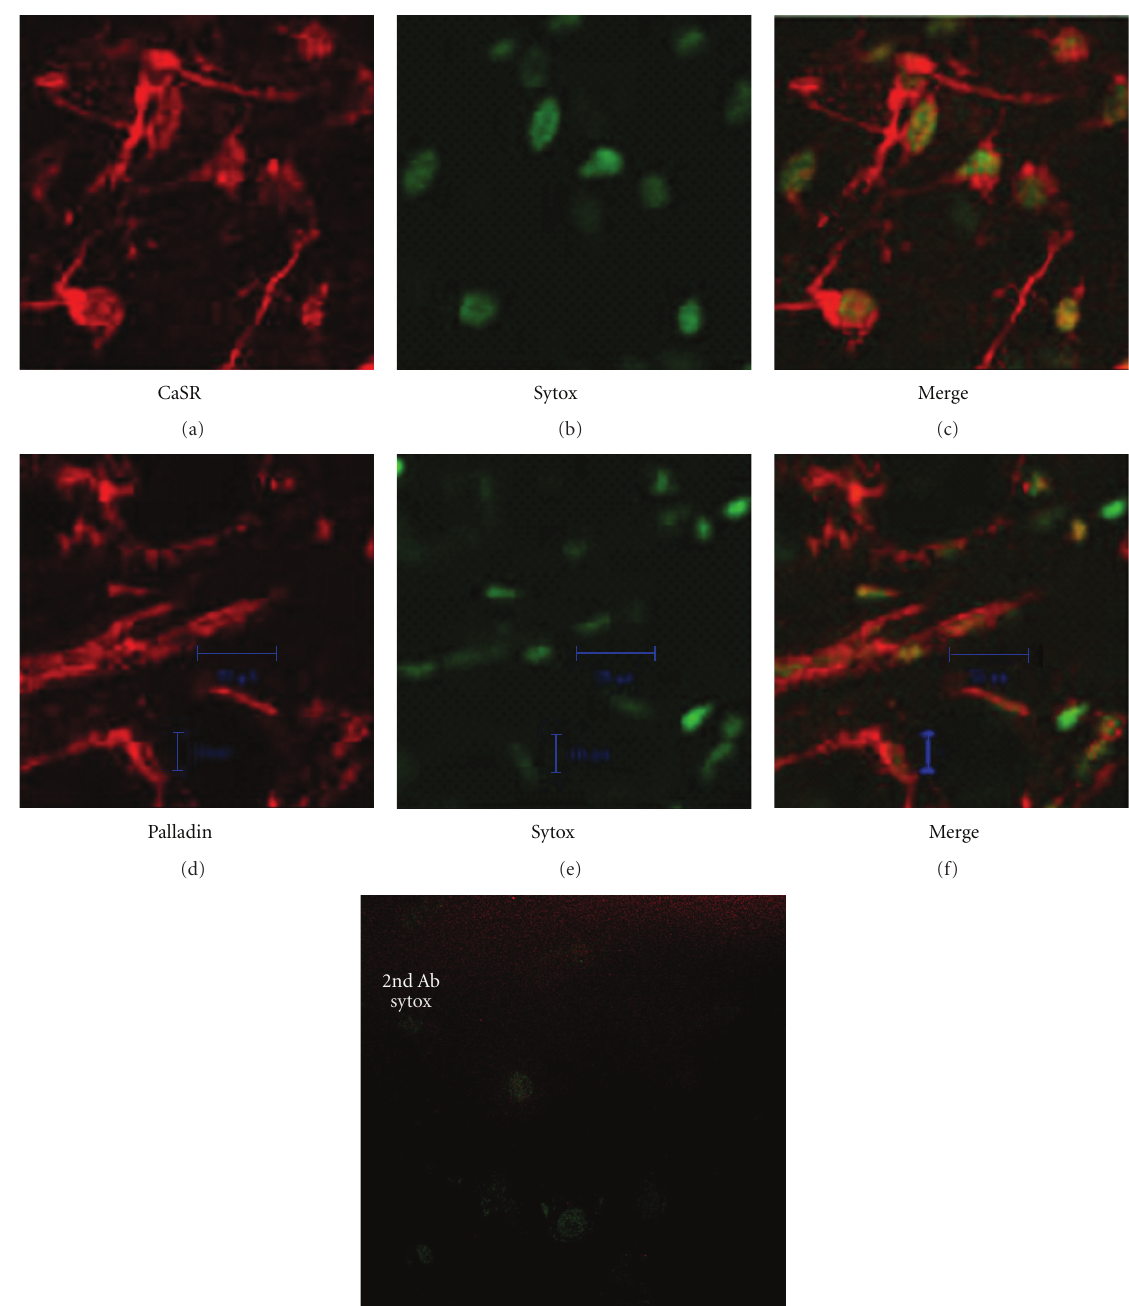
Figure 1: Immunofluorescent confocal analysis of the whole mount rat MBA showing the CaSR and palladin expression. ANNIES and the nerve fibers strongly express (94 ± 6%) the CaSR protein (top panel—in red, alexa fluor—647). Fibroblast like cells with no processes, and cells with nerve fibers (ANNIES) showing palladin expression (80 ± 10%) in red (lower panel). Nuclei stained in green (sytox)—(100x), (g). Rat MBA stained for secondary antibody alone, tagged with alexa fluor-647, and nuclear stain sytox—(100x). (Representative of 3